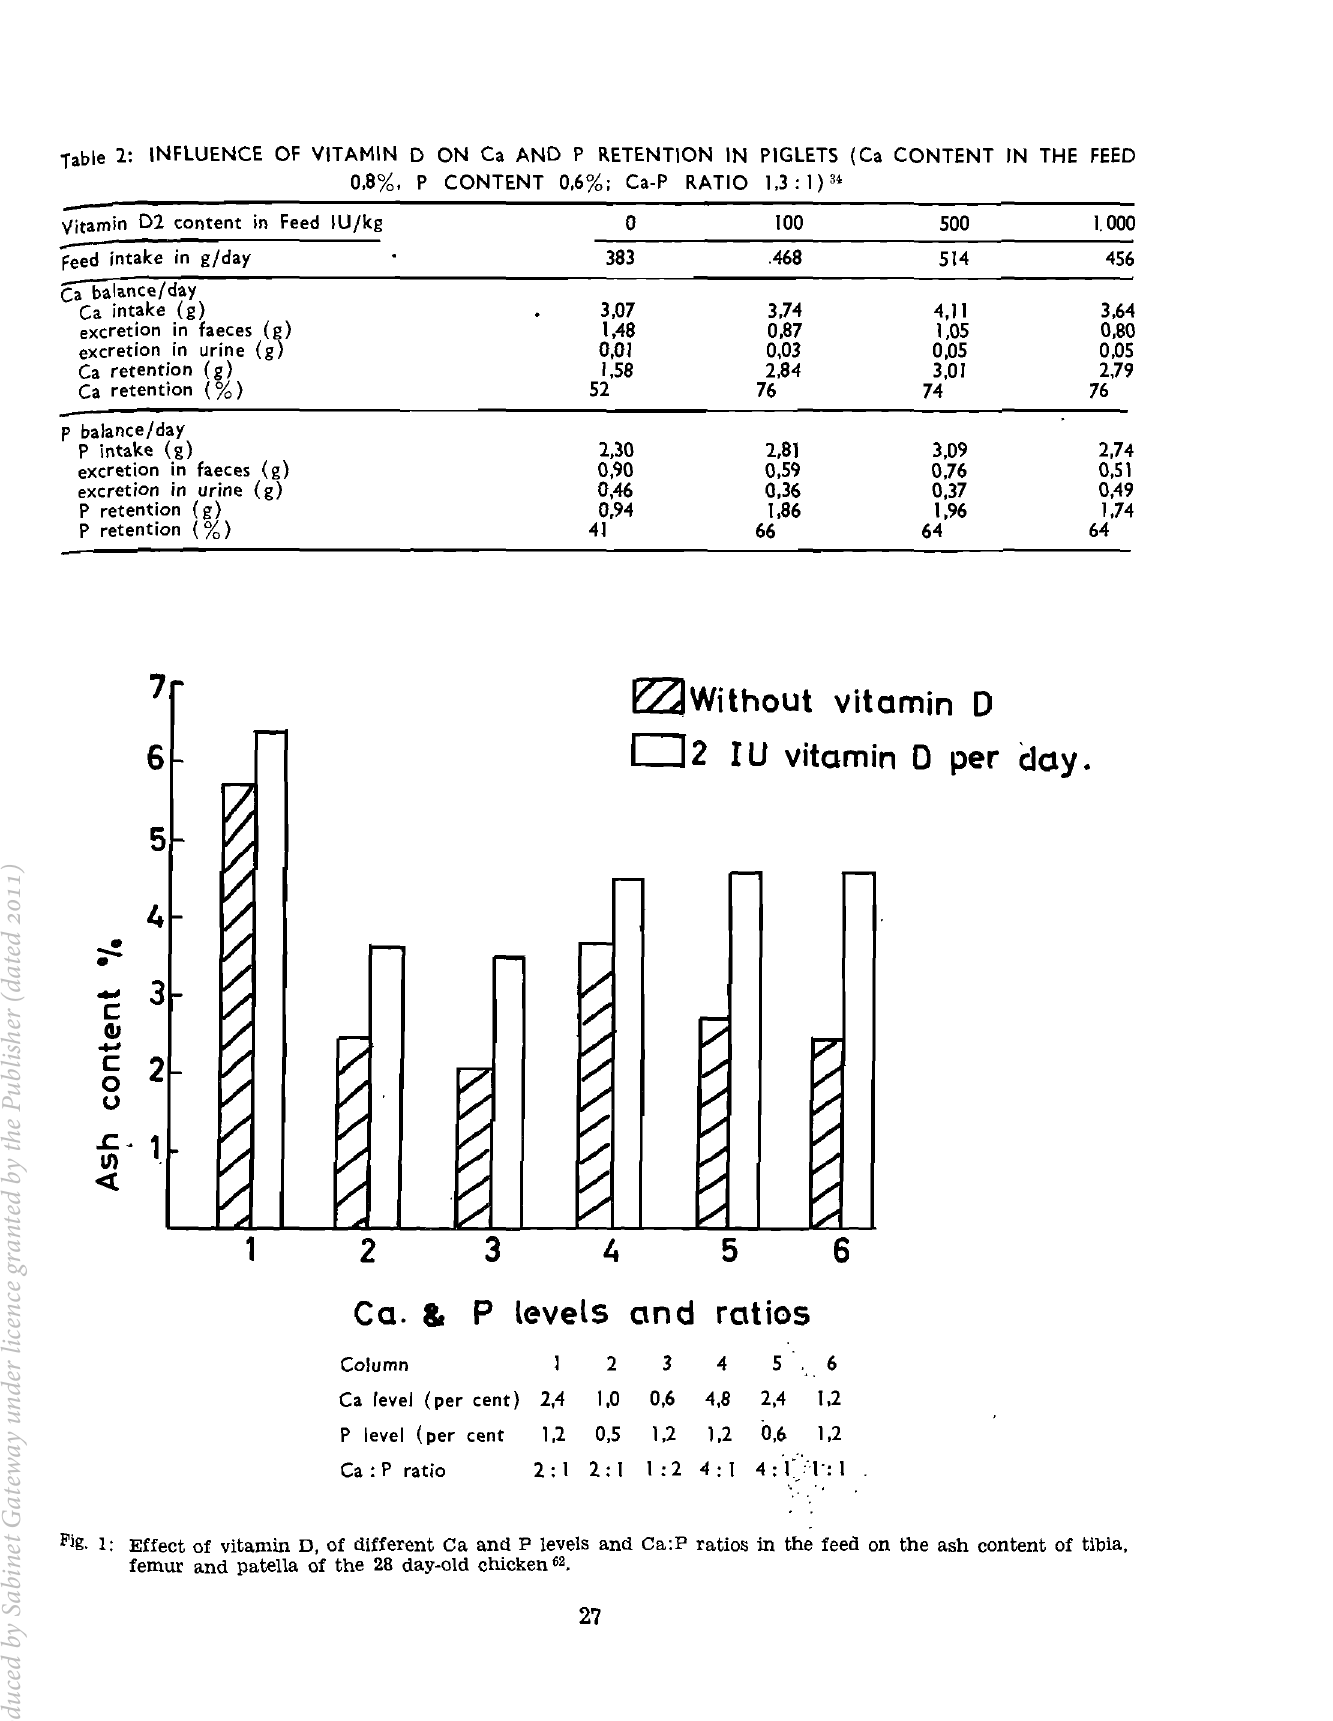
Table 2: INFLUENCE OF VITAMIN D ON Ca AND P RETENTION IN PIGLETS (Ca CONTENT IN THE FEED